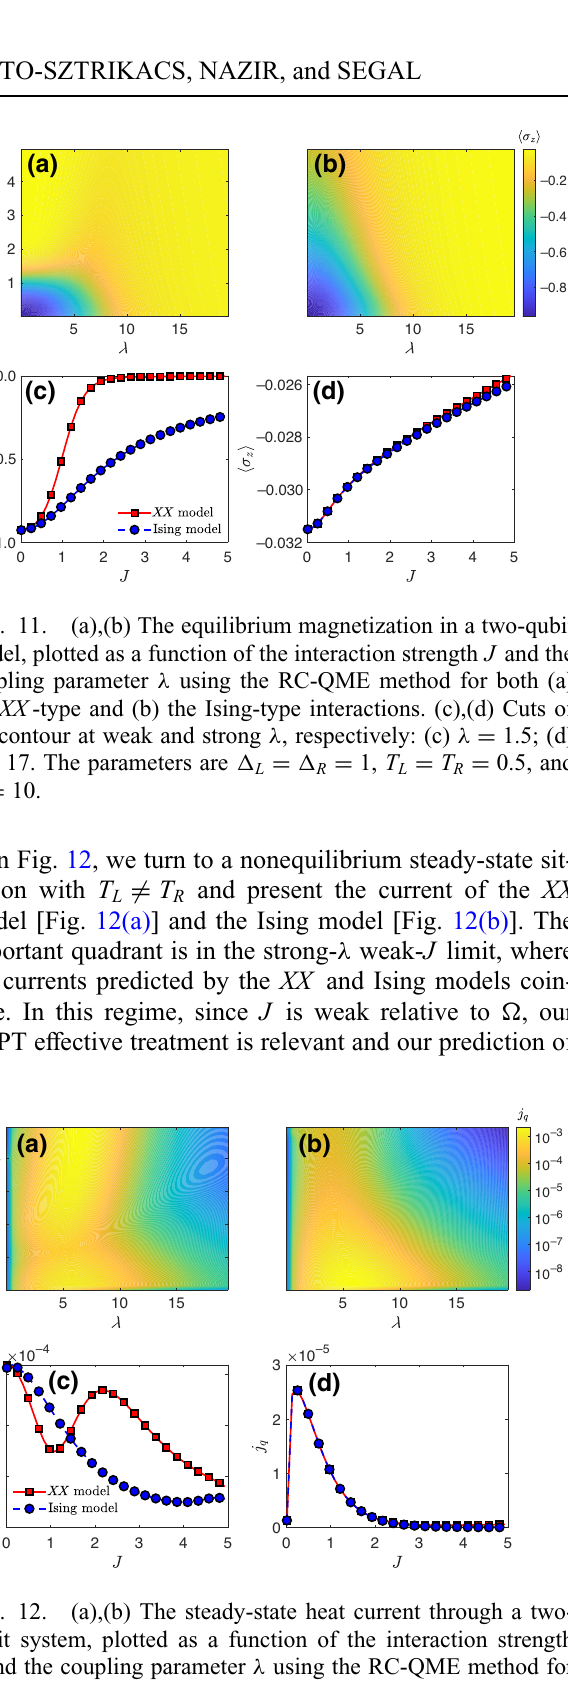
FIG. 12. (a),(b) The steady-state heat current through a two- qubit system, plotted as a function of the interaction strength J and the coupling parameter λ using the RC-QME method for both (a) the XX -type and (b) the Ising-type interactions. (c),(d) Cuts of the contour at weak and strong λ , respectively: (c) λ = 1.5; (d) λ = 17. The parameters are (cid:11) L = (cid:11) R = 1, T L = 0.5, T R = 1, and (cid:5) =